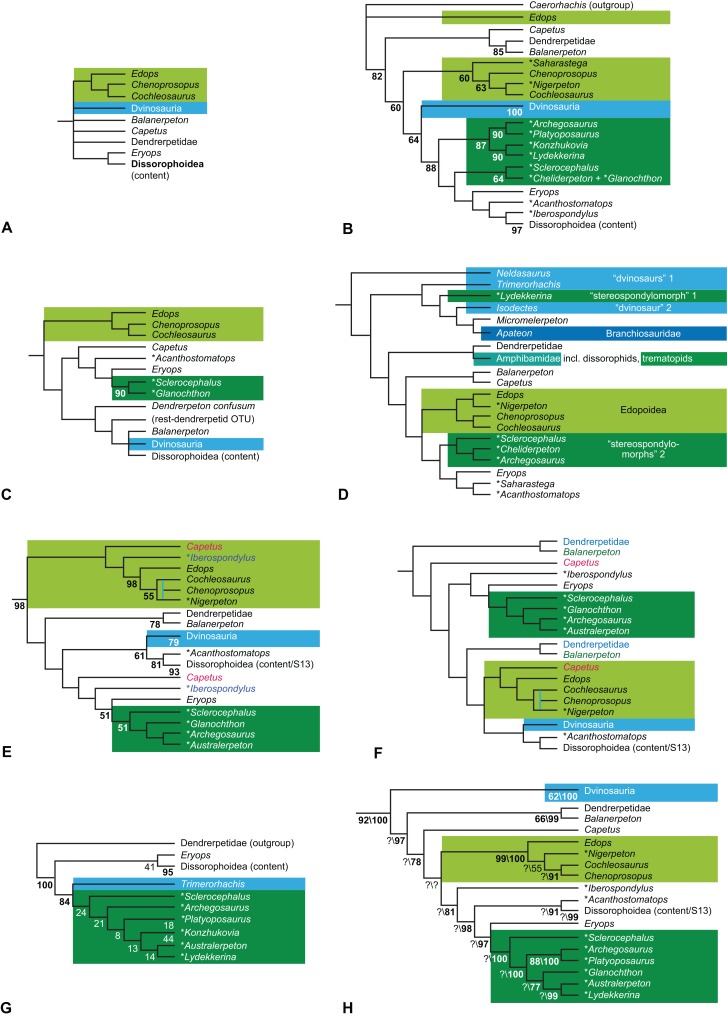
Hypotheses on temnospondyl phylogeny since 2006.Taxa absent from our expanded taxon sample are omitted, those we added to the sample of RC07 are marked with an asterisk. Dvinosauria and Dissorophoidea are collapsed where possible. The colored rectangles (labeled in D) and the terms “Dissorophoidea (content)” and “Dissorophoidea (S13)” are consistent with Figs. 1 and 10–20. The matrices of (A–C) are ultimately based on that of Ruta, Coates & Quicke (2003), so they—and ours (Fig. 26)—should not be considered fully independent of each other. Numbers below internodes are published bootstrap percentages; percentages below 50 were, except in (G), not reported. (A) Strict consensus of RC07; non-temnospondyls omitted. Dissorophoidea is marked in boldface for being extant because it contains Lissamphibia; this is the only analysis shown here that included any lissamphibians. RC07 (app. 4) performed a bootstrap analysis but did not publish the results for the part of the tree shown here. (B) Pawley (2006: chapter 5). “*Cheliderpeton + *Glanochthon” was a single OTU called “Cheliderpeton spp.”; the name Glanochthon had not yet been coined. *Acanthostomatops was included as part of a Zatracheidae OTU. (C) Ruta (2009), strict consensus of analysis without reweighting; non-temnospondyls omitted. *Glanochthon latirostris was called by its previous name, “Cheliderpeton latirostre”. The “rest-dendrerpetid OTU” was called “Dendrerpeton acadianum”, but may have contained information from other dendrerpetids as well; see Materials and Methods: Treatment of OTUs: Dendrerpetidae. (D) McHugh (2012); non-temnospondyl omitted. Dissorophidae (as two clades, one of which contains Broiliellus brevis) and Trematopidae (also as two clades) are nested in three different places within Amphibamidae. All bootstrap percentages of the nodes shown here are below 50 and were not published. (E, F) All equally parsimonious topologies (8 MPTs) from the analysis of 48 taxa in Dilkes (2015a); non-temnospondyls omitted. Note (in F) that Dendrerpetidae and Balanerpeton are sister-groups in all MPTs. To see the individual MPTs, we repeated the analysis (calculation time: 00:04:36.5), finding MPTs of the same number, length and indices as published by Dilkes (2015a). The bootstrap percentages are from Dilkes (2015a: fig. 11B), which shows an analysis where Capetus and *Iberospondylus were omitted; the topology is otherwise identical to (E). (G) Pereira Pacheco et al. (2017), focused on stereospondylomorphs. Two species of *Platyoposaurus and three of *Konzhukovia were included as separate OTUs. The tree by Eltink et al. (2016) is fully compatible. (H) Pardo, Small & Huttenlocker (2017); non-temnospondyls and lissamphibians omitted (the MPTs differ only in the positions of the lissamphibians and **Chinlestegophis). Numbers are bootstrap percentages followed by Bayesian posterior probabilities in % (boldface if ≥ 75, not published < 50).